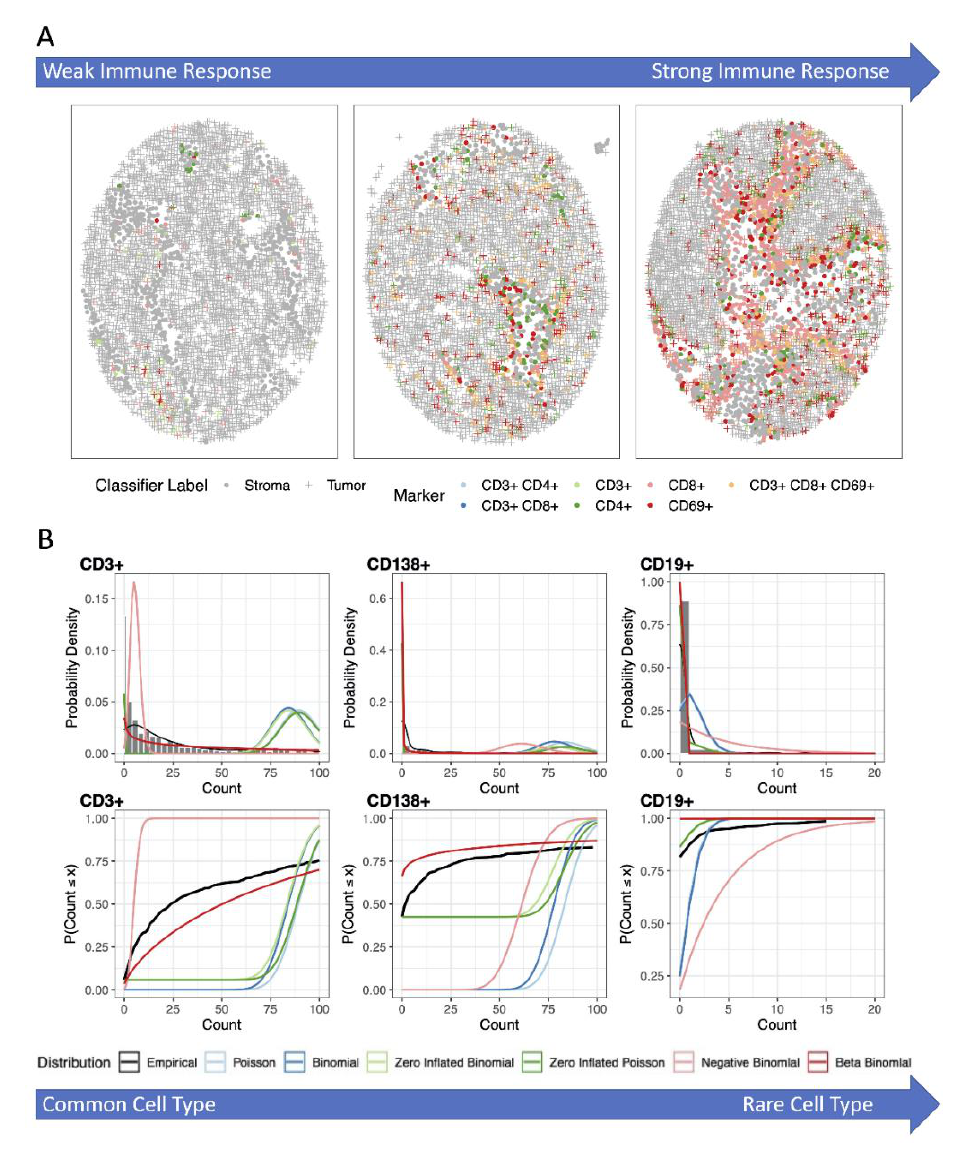
Figure 3. ( A ) Illustration of the possible differences in immune activity within TMA cores. ( B ) Histograms with empirical and theoretical probability density function (top) and empirical and theoretical cumulative probability distribution (bottom) to guide in the selection of modelling assumptions for markers becoming increasingly rare (from left to right). The Poisson and binomial distribution do not account for overdispersion or zero-inflation, negative binomial and beta-binomial only account for over dispersion, and zero-inflated Poisson and binomial distribution only account for zero-inflation. The negative binomial and beta-binomial distributions are suitable for cell types where less than 50% of the cores have 0 for that cell type (CD3+, CD138+), while zero inflated models are best for excess 0s (CD19+).